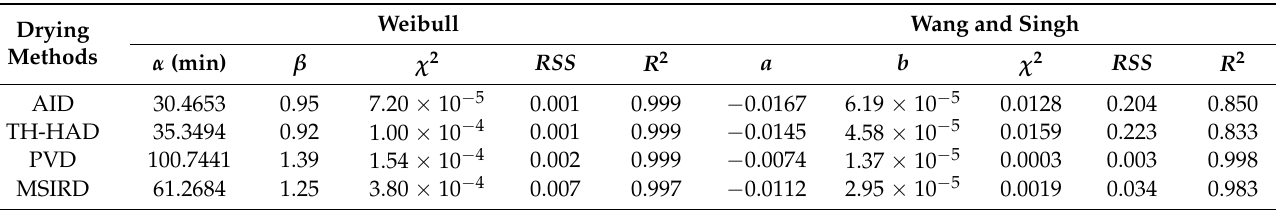
Table 1. Modeling of drying curves under various drying